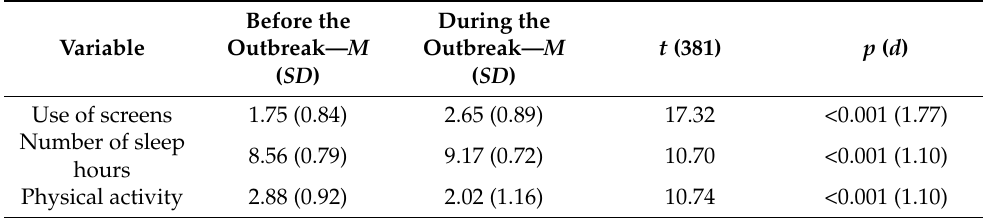
Table 6. Paired sample t -test results for the Children’s number of hours a day spent in screens, sleep, and physical activities both before and during the Coronavirus outbreak as reported by their parents Before Variable